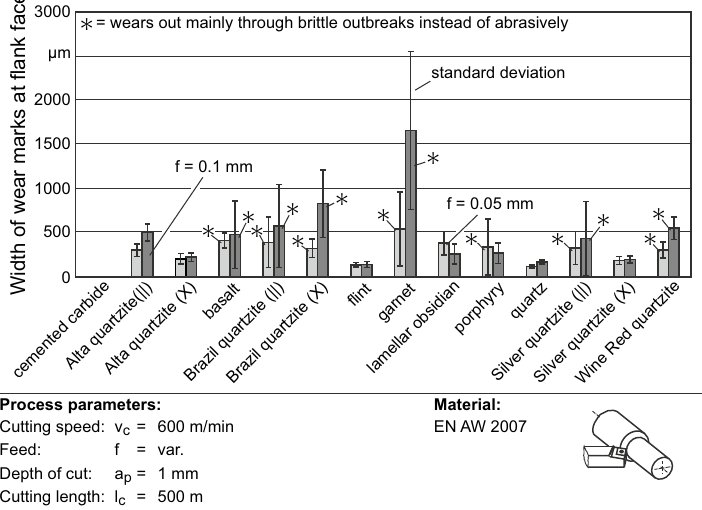
Fig. 18 Width of wear marks at the flank face of the rock inserts for a depth of cut of 1